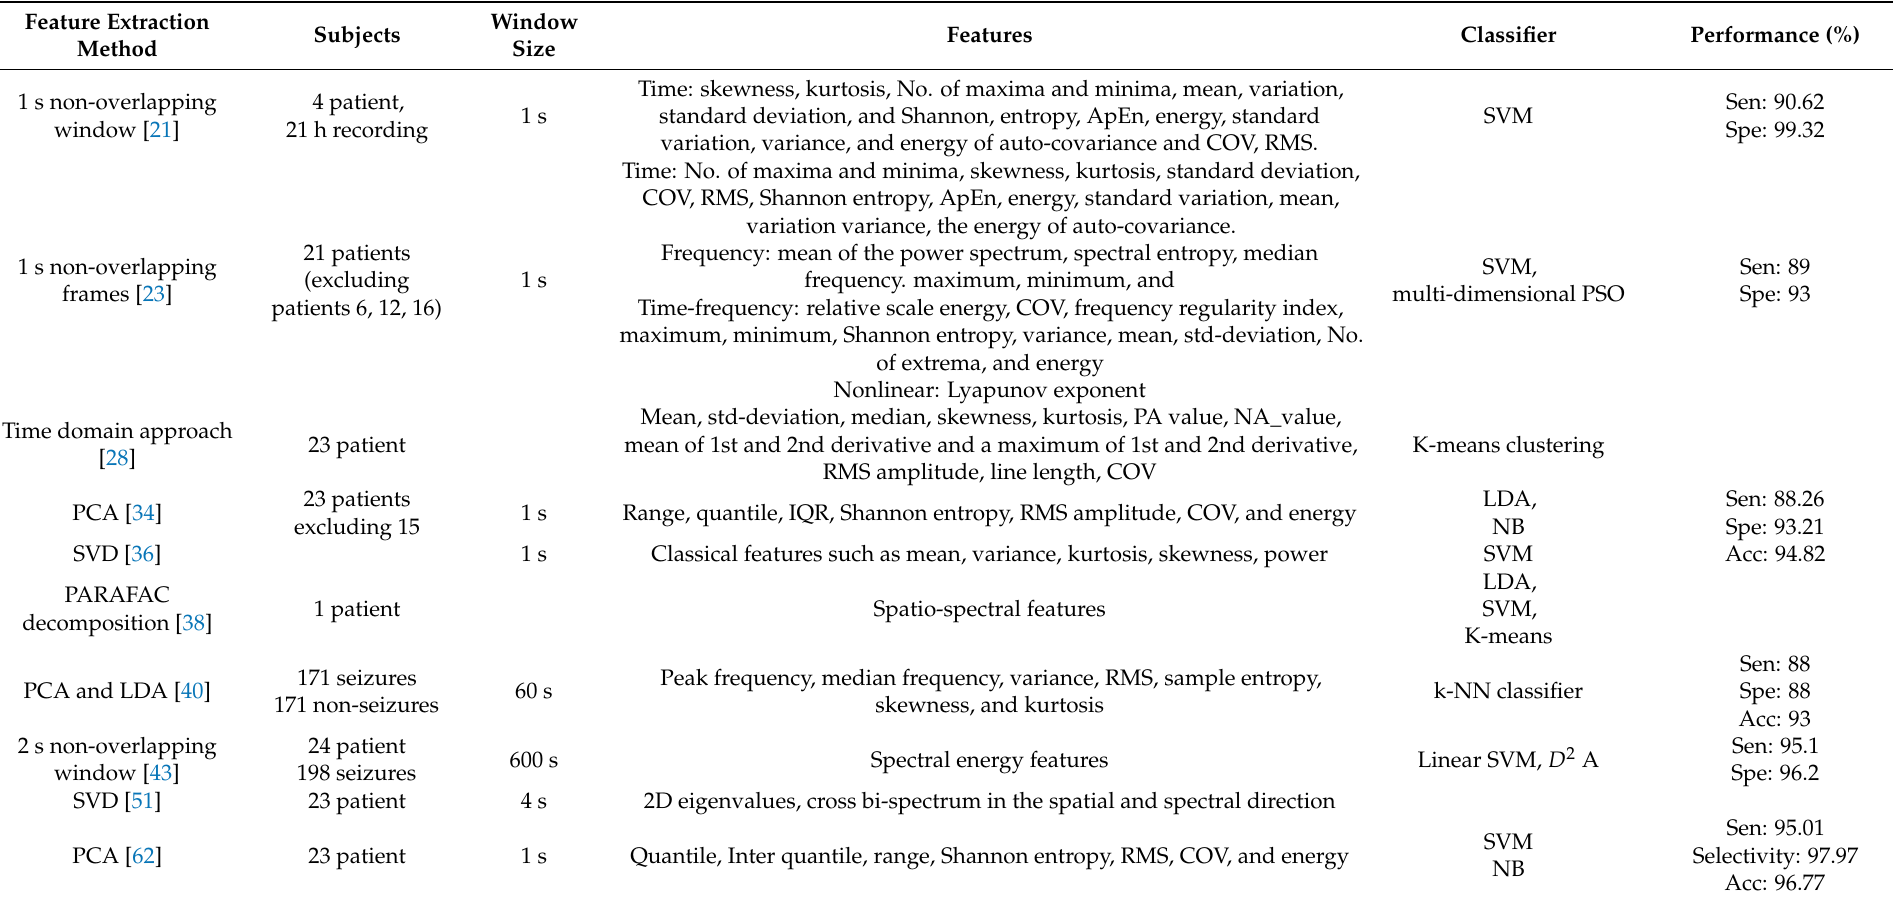
Table 1. Summary of epileptic seizure detection approaches in the time